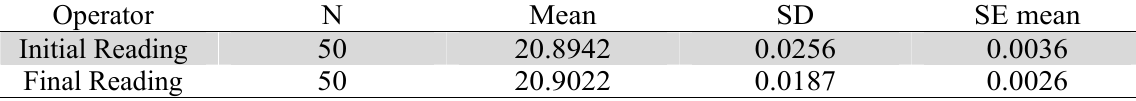
Two-sample t-test: Component Alignment (Gap Maintain) Two-sample t-test: Lock nut